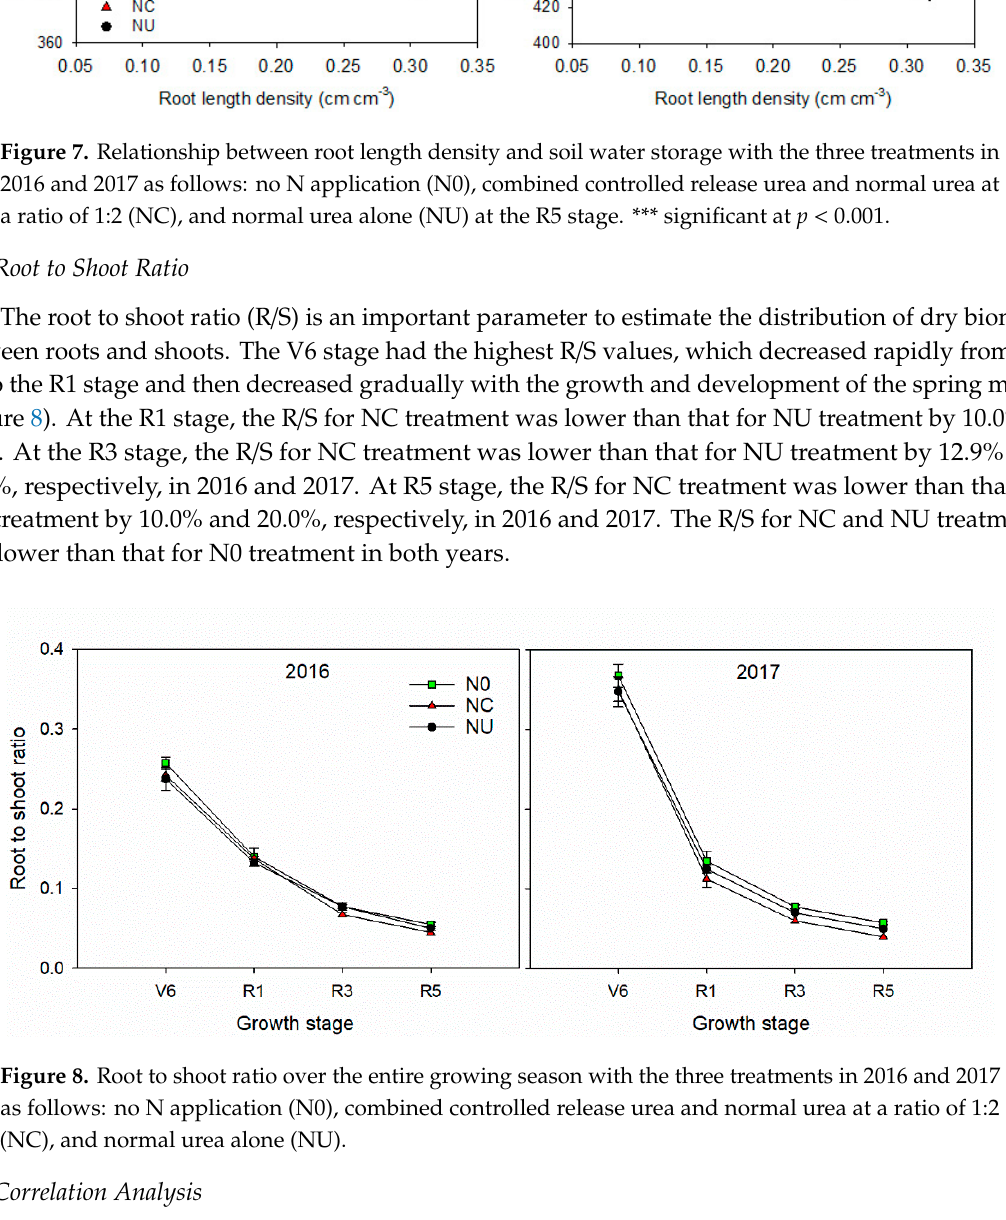
Table 3. Correlation coefficients between root parameters (root length density (RLD) and root weight density (RWD)) over various soil depths with different growth stages under three N application treatments and maize grain yields. Year